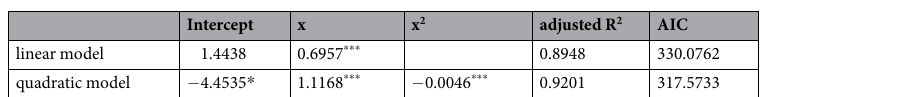
Table 1. Parameters and Akaike information criterion of the linear and the quadratic model fitted to the data of Fig. 1. * p < 0.05, *** p <